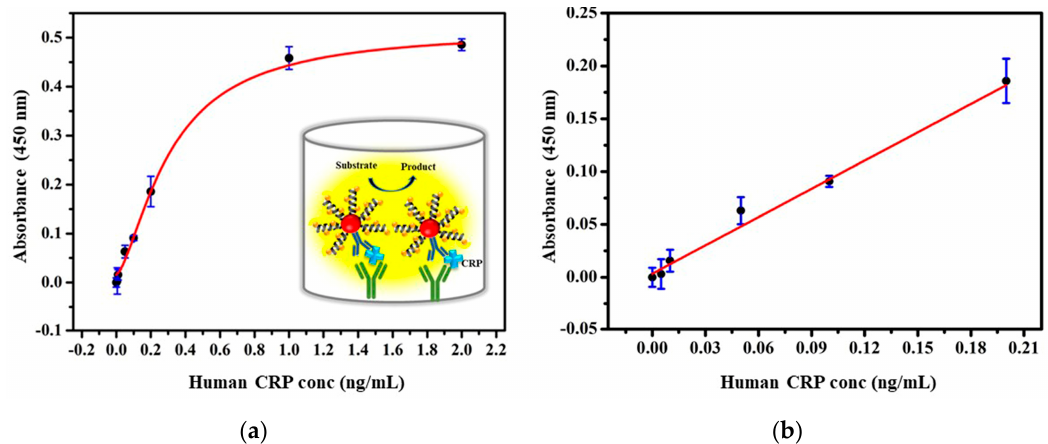
Figure 5. Plot represented the performance of assay ( a ) validation of developed nanoprobe for CRP detection in human serum samples. Error bar indicates the standard deviation of three repeated experiments (black dots) and ( b ) along with the fitted curve.